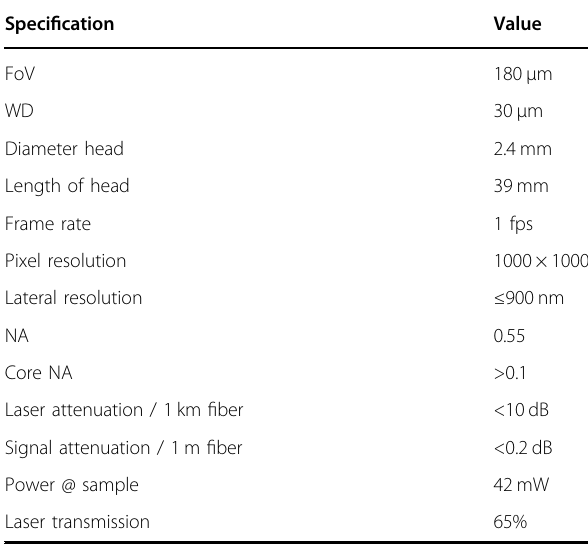
Table 1 List of key speci fi cations of the endomicroscopic